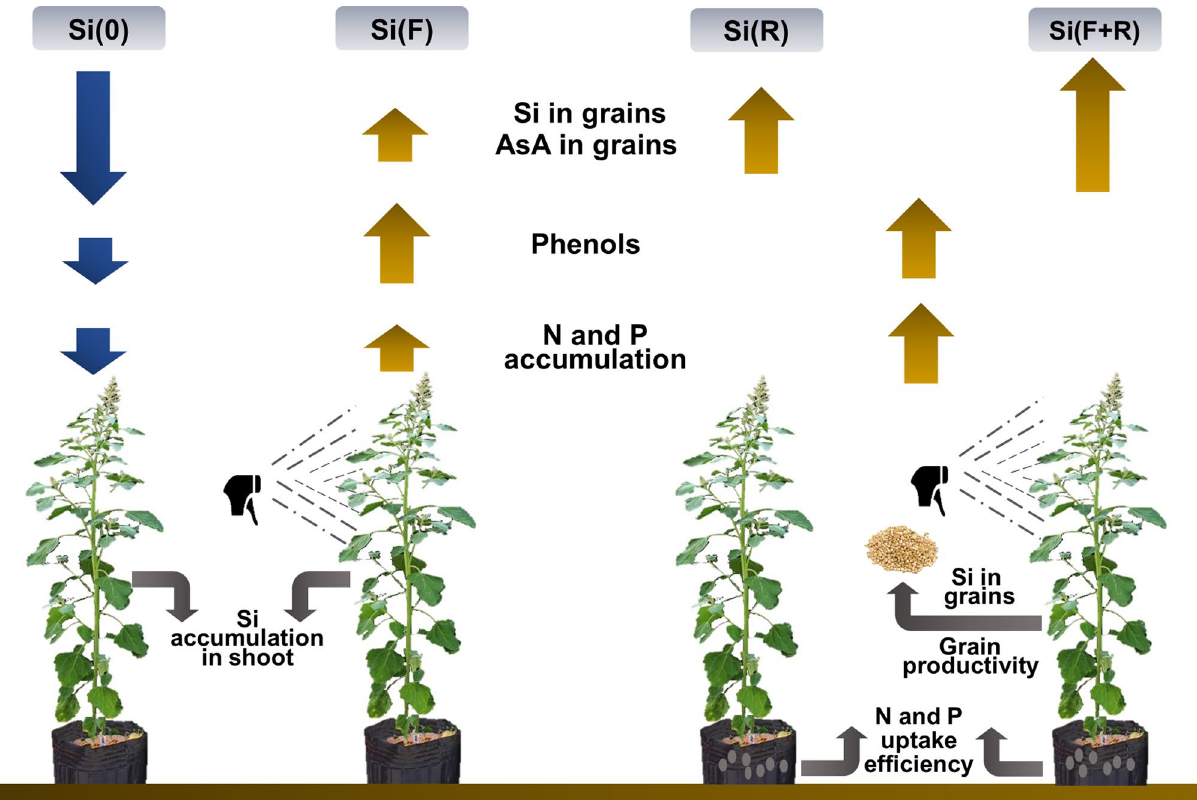
Figure 5. Graphical abstract of the forms of application of Si in quinoa and main results in productivity and grain